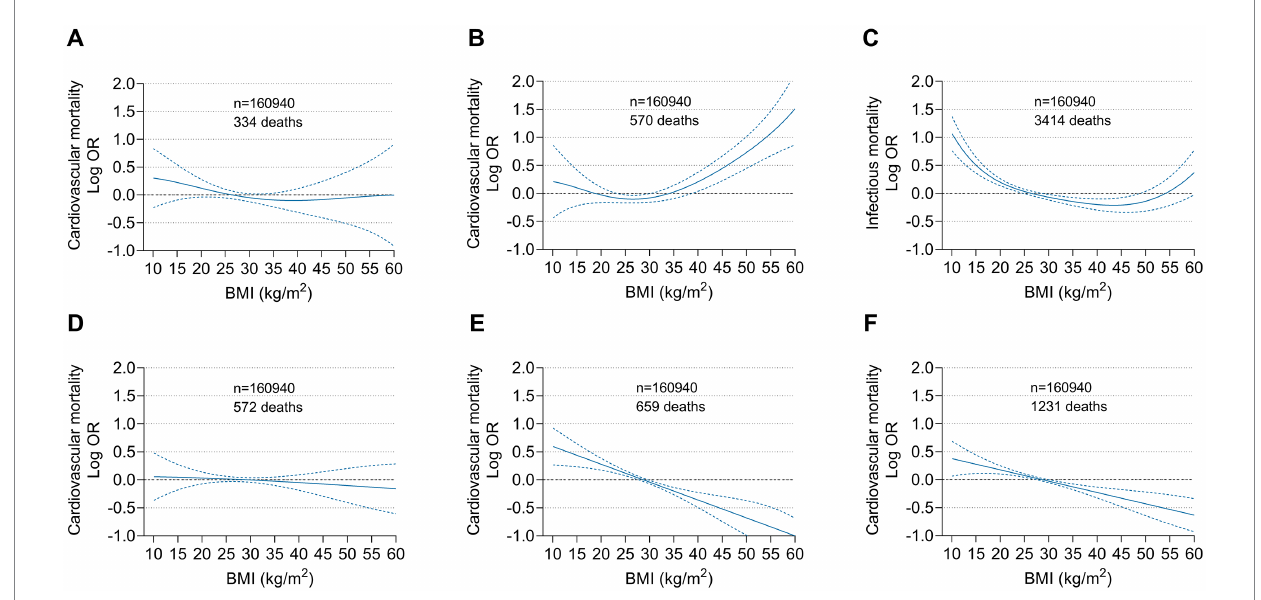
FIGURE 5 Multivariable adjusted odds ratios for specific disease related mortality according to BMI on a continuous scale. (A) Myocardial infarction, (B) Heart failure, (C) Sepsis, (D) Ischaemic stroke, (E) Intracranial hemorrhage and (F) Ischaemic and hemorrhagic stroke related mortality among the overall population. Odds ratios (solid line) and 95% confidence intervals (dashed lines) were from cubic spline curves based on the generalized additive